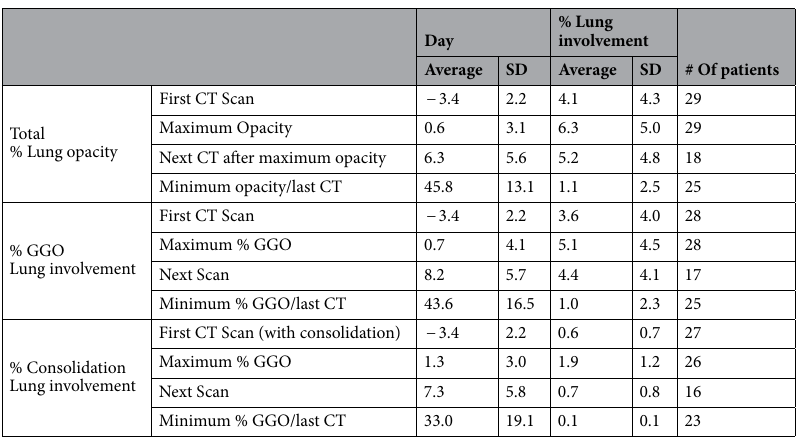
Table 1. Data used to generate the dynamic curves for percent lung opacity.